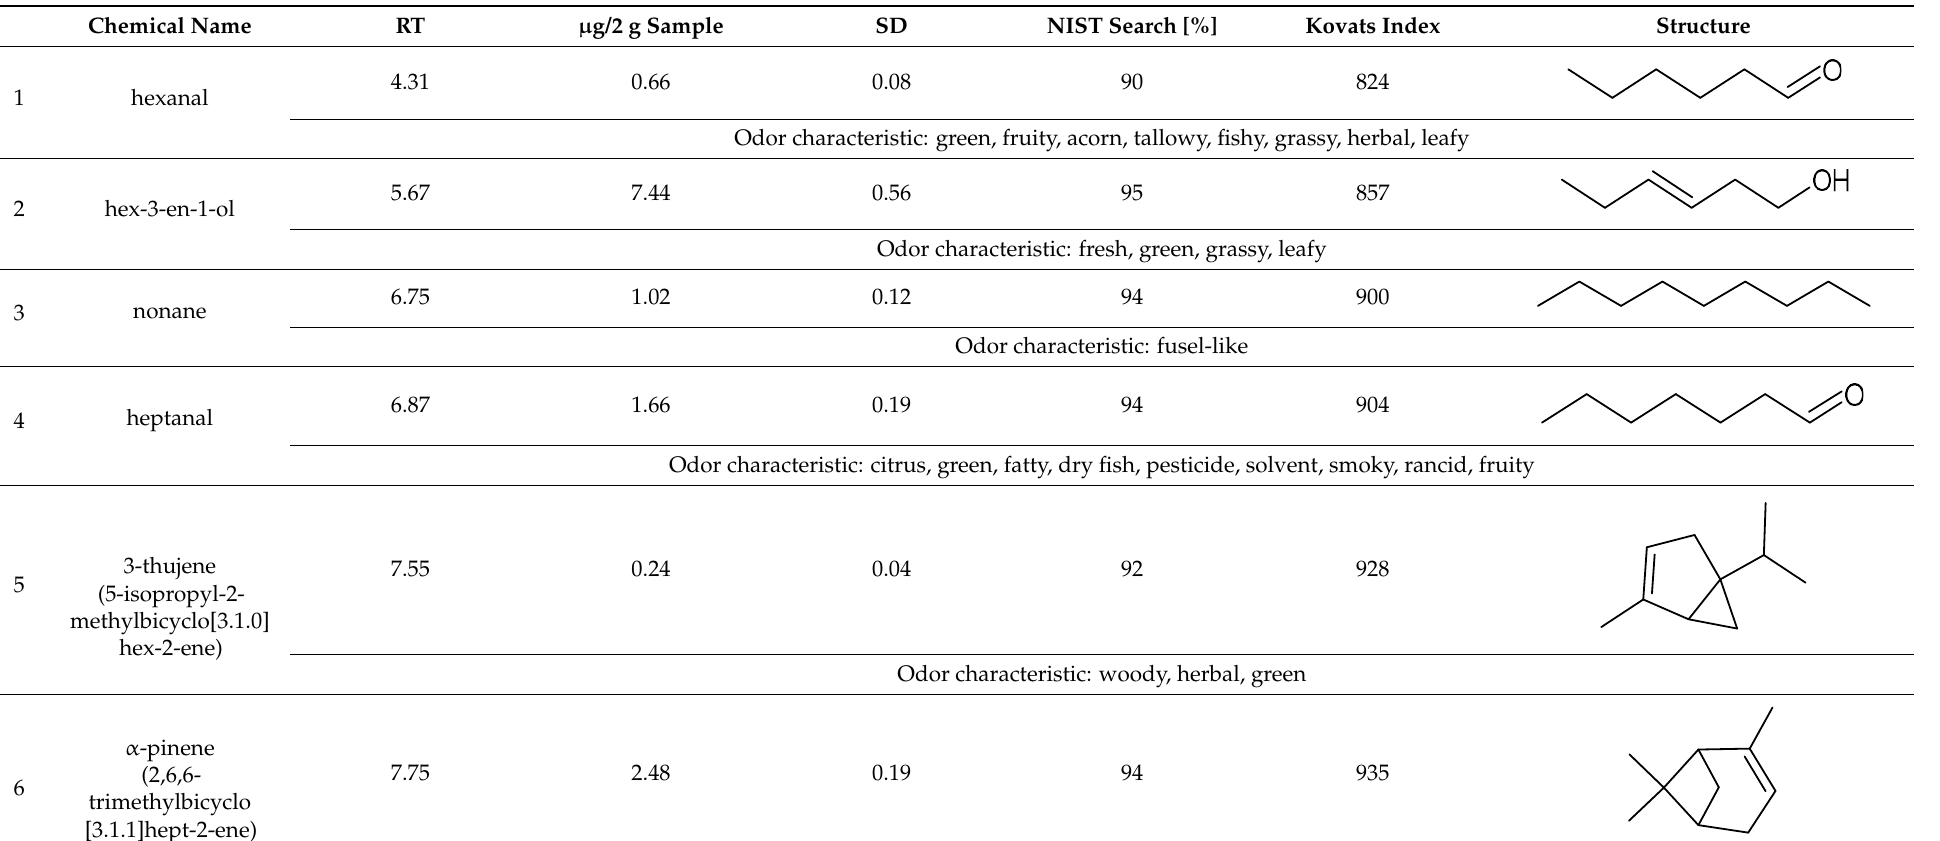
Table 1. List of volatile organic compounds (VOCs), its chemical structure, and odor characteristic identified in Fallopia baldschuanica . Abbreviation: RT—retention time/minutes; SD—standard deviation.